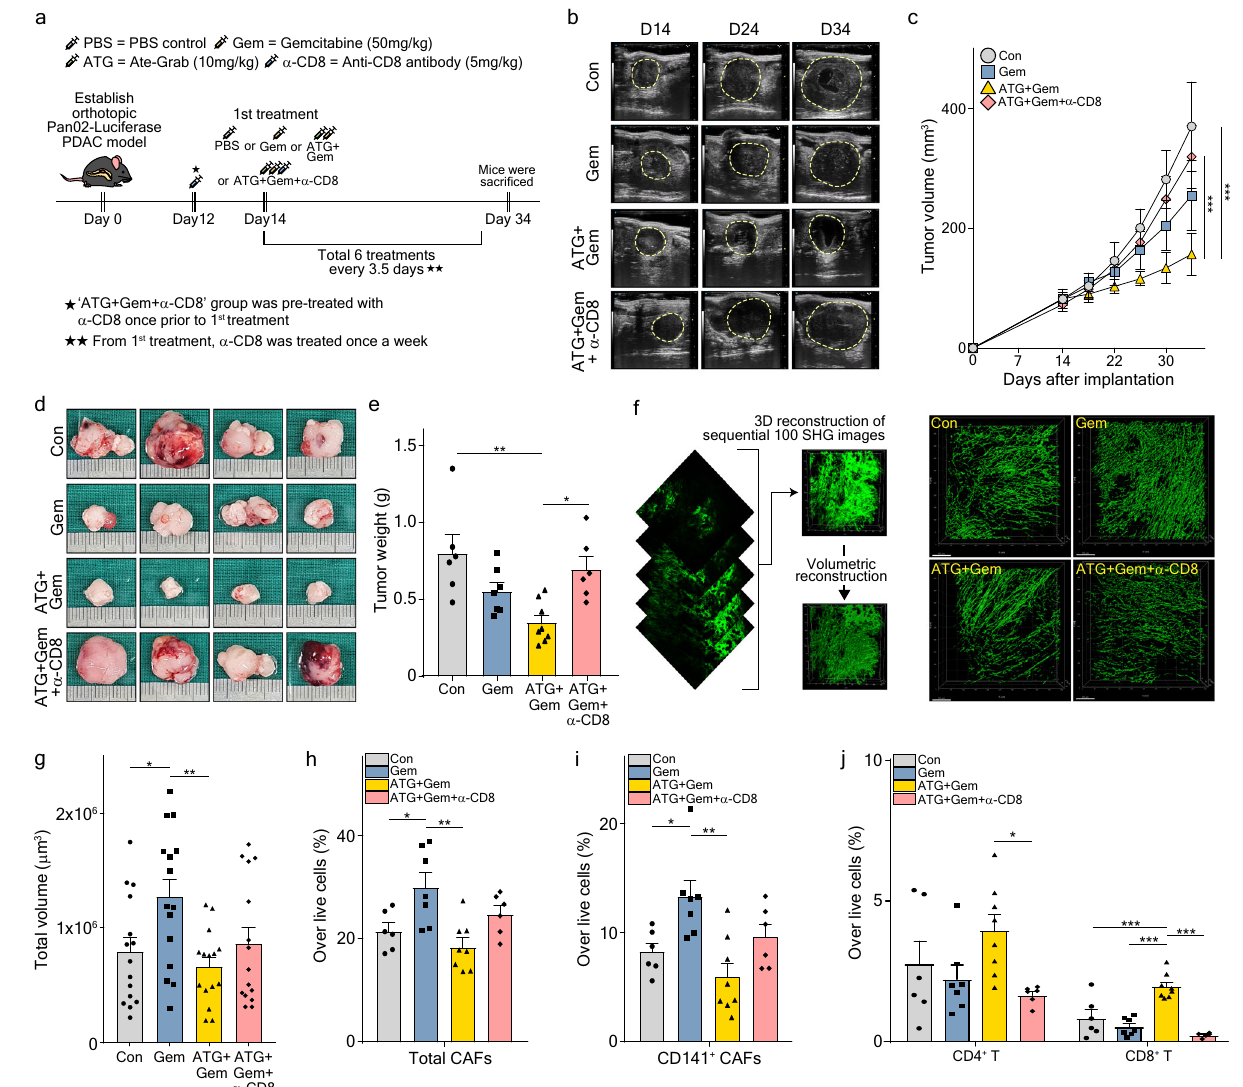
Fig. 7 | CD8 + T cell mediates antitumor and anti- fi brotic effects of Ate-Grab. a Experimental treatment scheme. When the tumor volume reached 50 – 100mm 3 , tumor-bearing mice were intraperitoneally treated with either PBS (control), gemcitabine (50mg/kg, every 3.5 days), gemcitabine with Ate-Grab (10mg/kg, every 3.5 days), or gemcitabine with Ate-Grab and anti-CD8 antibody (5mg/kg, once a week). b Representative ultrasonographic images for orthotopic Pan02- Luciferase tumor growth in vivo. c Tumor volumes compared across indicated treatment groups (Con, n =6; Gem, n =7; ATG+Gem, n =8; ATG+Gem+ α -CD8, n =6). Con, control; Gem, gemcitabine; ATG+Gem, Ate-Grab and gemcitabine co- treatment; ATG+Gem+ α -CD8, Ate-Grab, gemcitabine, and α -CD8a antibody co- treatment. *** P <0.001. two-way ANOVA with Tukey ’ s multiple comparisons. d Representative images of KPC tumors from indicated treatment groups. Ruler scale, 1mm. e Tumor weights compared across indicated treatment groups (Con, n =6; Gem, n =7; ATG+Gem, n =8; ATG+Gem+ α -CD8, n =6).Data are presented as the mean±SEM. * P <0.05 (ATG+Gem vs ATG+Gem+ α -CD8: P=0.018), ** P <0.01 (Con vs ATG+Gem: P =0.002), one-way ANOVA with Tukey ’ s multiple comparisons. f Schematic diagram of 3D reconstruction of collagen fi bers using